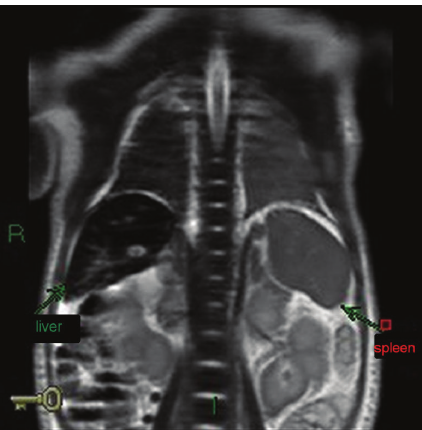
Figure 1: Abdominal MRI, coronal view, on day five of life showing low signal intensity of the liver parenchyma with preservation of the signal intensity of splenic parenchyma (T2WI protocol). Calcula- tions of T2 ∗ showed rapid decay consistent with iron overload.